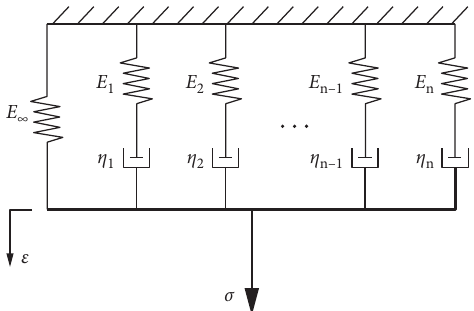
Figure 1: Generalized Maxwell model